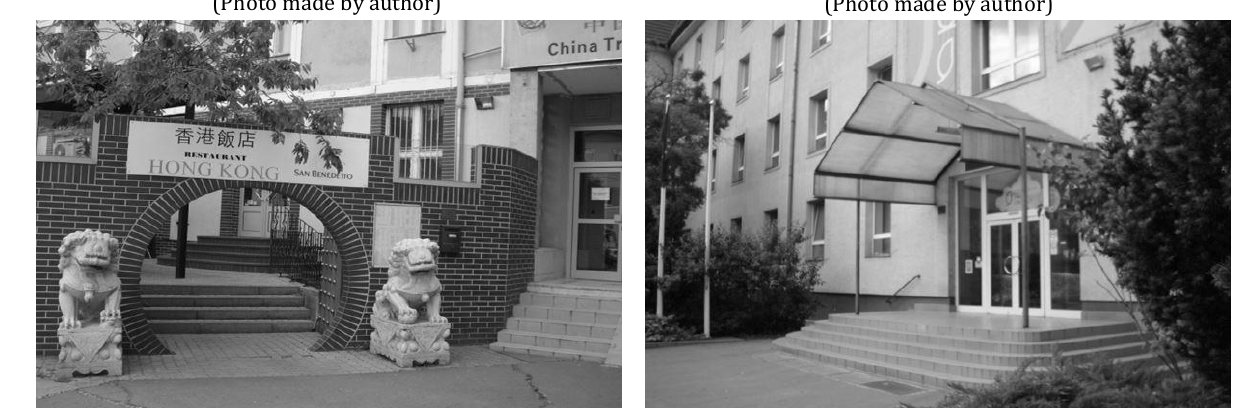
Fig. 11. Ex-garrison in Fáy street, Budapest, Chinese Trade Fig. 12. János Kodolányi